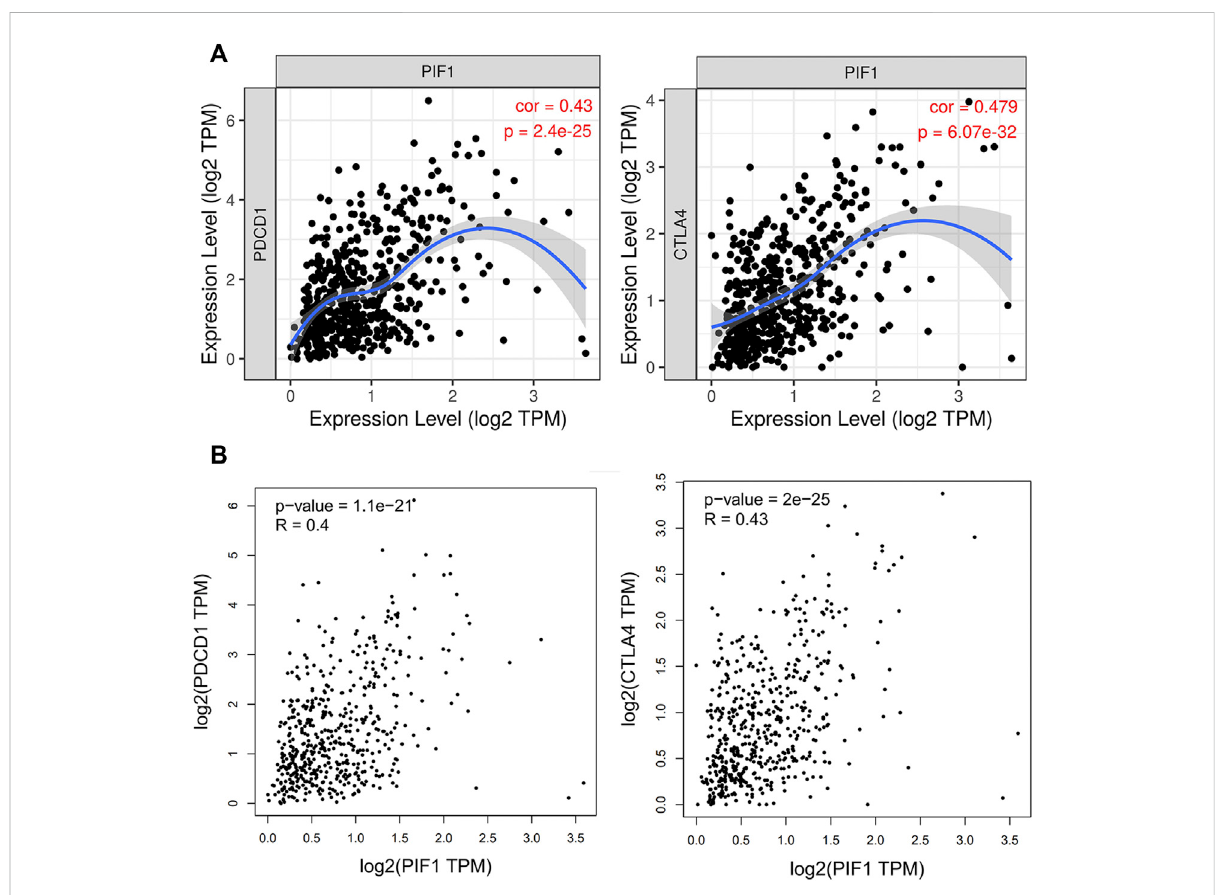
FIGURE 9 Relationship between PIF1 and PD1 in ccRCC. (A) Spearman correlation of PIF1 with the expression of PD-1/CTLA4 in ccRCC adjusted by purity usingTIMER. (B) The expression correlation ofPIF1 withPD-1/CTLA4inccRCCwasdetermined bytheGEPIAdatabase.ccRCC: ClearCell RenalCell